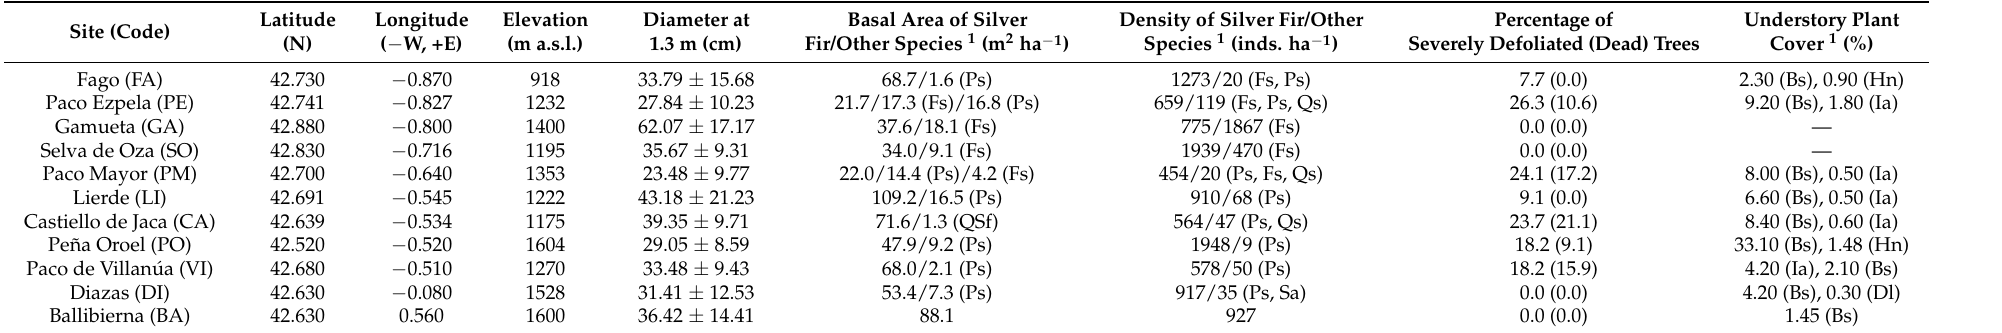
Table 1. Studied stands, and their location and main characteristics. For each stand, the latitude, longitude and elevation is shown together with the average diameter of silver fir trees, the basal area and tree density. In addition, the percentage of trees severely defoliated (defoliation classes 3–5) and dead, as well as the cover of the main understory plant species present in the transect, is